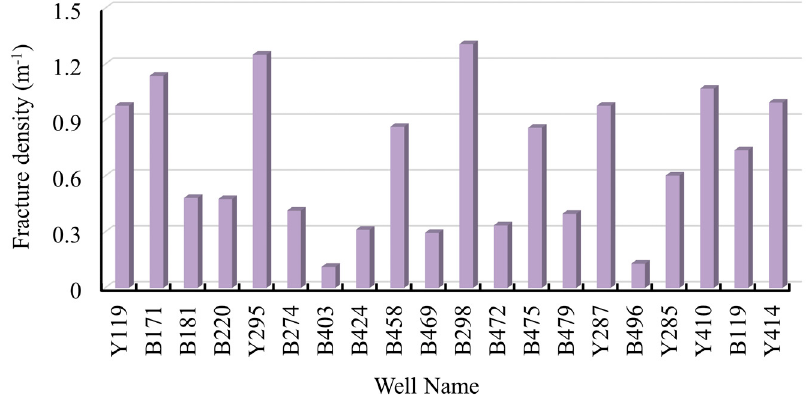
Figure 5. Histogram of core fracture density.